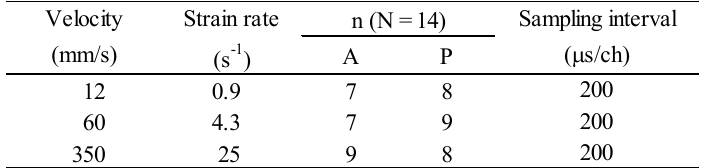
Table 1: Loading rate, sample location, and sampling interval for the rate sensitivity test.